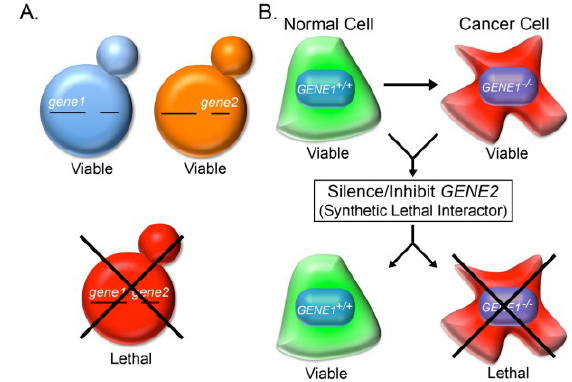
Figure 1. Synthetic Genetic Approaches in Model Organisms and Cancer. ( a ) Synthetic lethality is a rare genetic interaction that occurs when two independent and viable mutations or deletions ( gene1 [blue yeast] or gene2 [orange yeast]) result in death